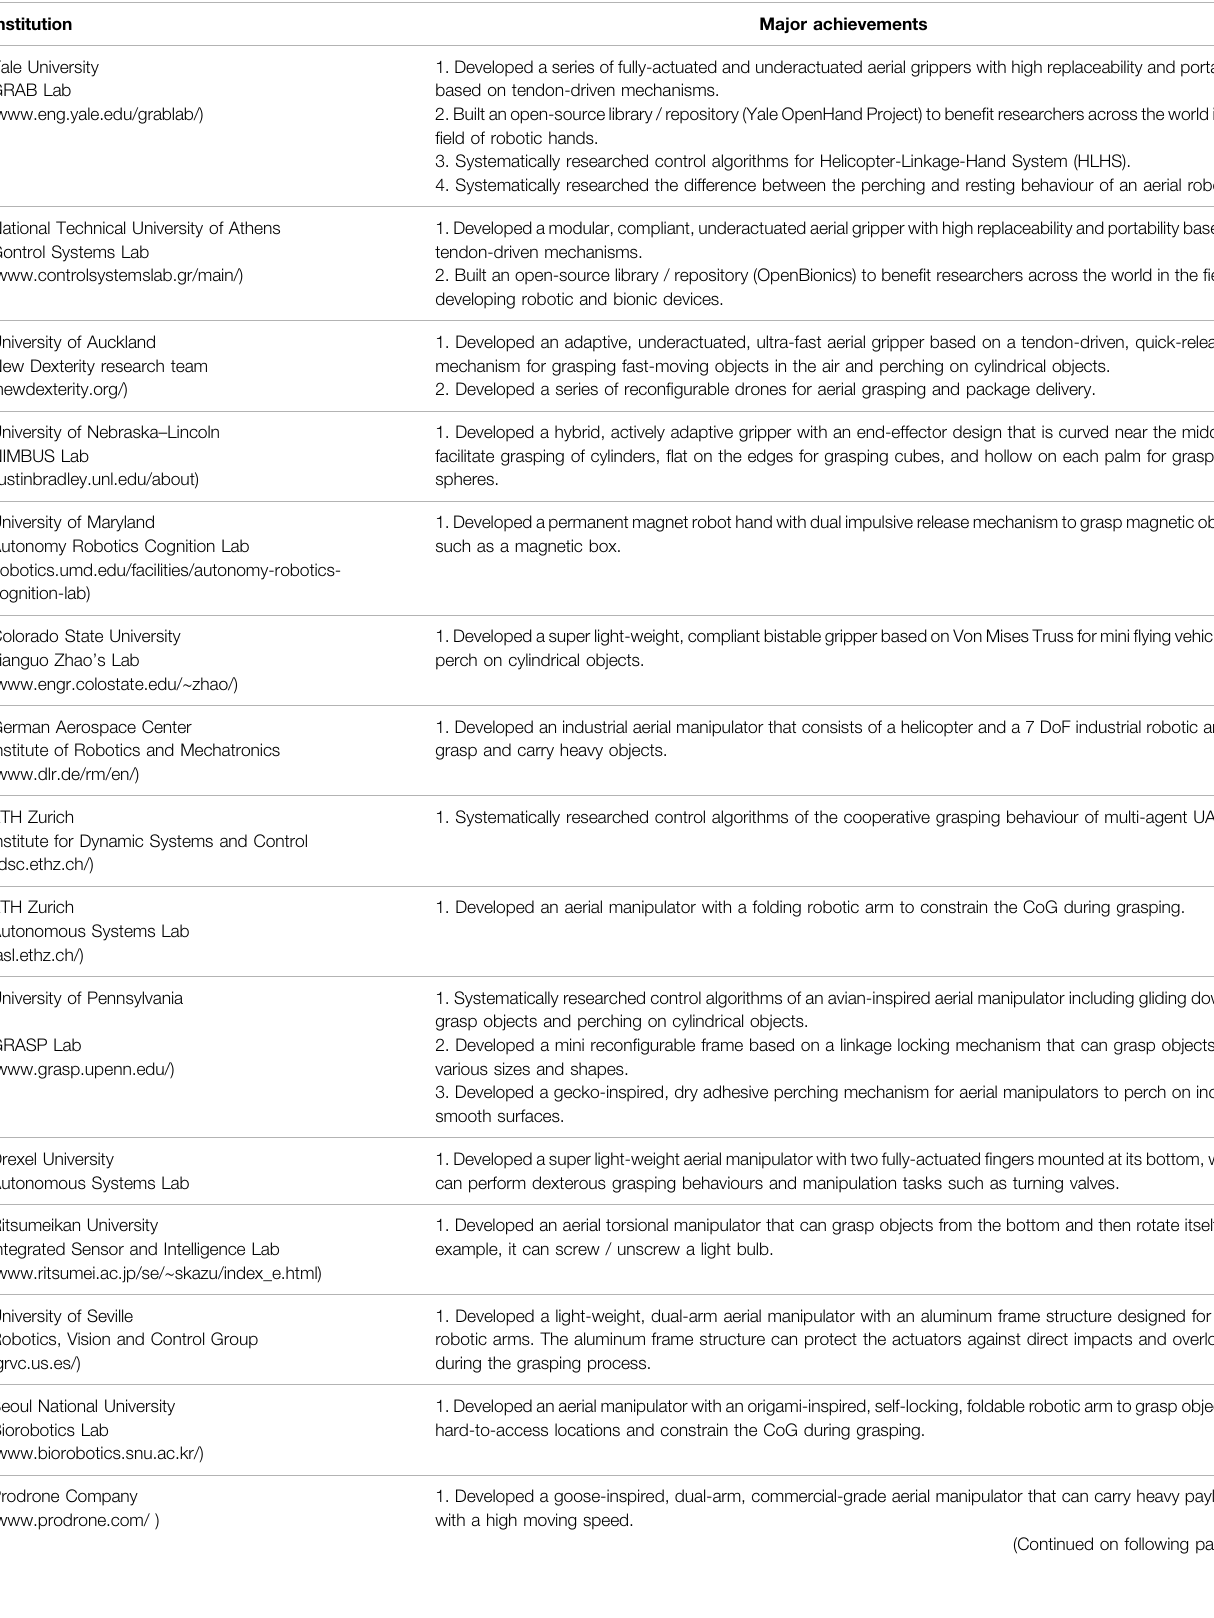
TABLE 6 | Major achievements of laboratories, research groups, and companies for aerial robots with grasping and perching